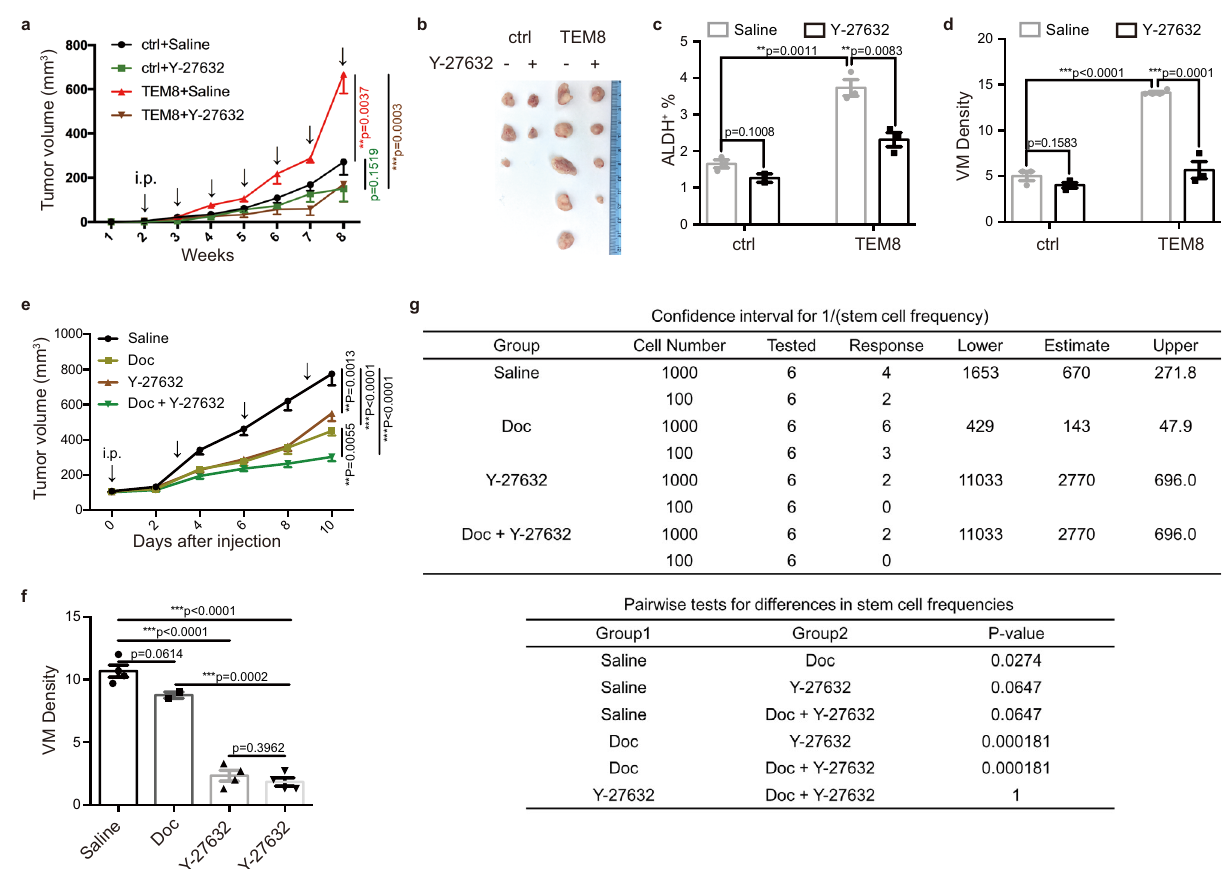
Fig. 5 ROCK1i suppressed TEM8 effects on VM and tumorigenesis. a – d The effect of Y-27632 treatment (10 mg/kg, intraperitoneally, weekly) on MDA- MB-231 cell (TEM8-overexpressing and ctrl) tumor growth in nude mice (three mice per group, two sites each mouse, 2 × 10 6 cells/site). The tumor growth curve ( a ) and representative image of tumors ( b ) were shown. Time points of treatment were indicated by black arrows. Tumor cell ALDH activity was determined by ALDEFLUOR assay and the bar plot (mean ± SEM) was shown ( c ). Tumor vasculogenic mimicry was stained and the bar plot (mean ± SEM) was shown ( d ). e , f The effect of Y-27632 treatment (10 mg/kg, intraperitoneally, every three days) combined with docetaxel therapy (10 mg/kg, intraperitoneally, every three days) on TNBC PDX15 tumor growth in NOD/SCID mice (six mice for each group, two sites each mouse, 10 5 cells/site). The tumor growth curve was shown ( e ). Time points of treatment were indicated by black arrows. Tumor vasculogenic mimicry was stained and the bar plot (mean ± SEM) was shown ( f ). g Tumor cells (H2kd − ) isolated from Y-27632 and/or docetaxel-treated PDX15 tumor were engrafted in limited dilution to mammary fat pads of NOD/SCID mice (three mice for each group, two sites each mouse, 100 or 1000 cells/site). The stem cell frequency and p value calculation were based on the positive tumor sites. Source data are provided as a Source Data fi